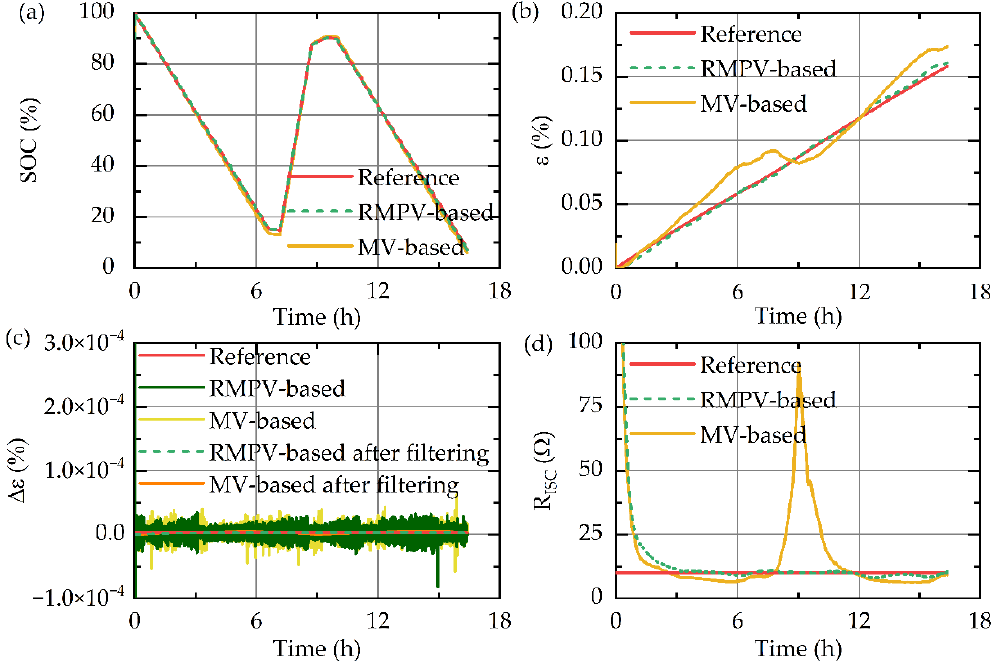
Figure 9. Estimation results with a 10 Ω -ER: ( a ) SOC estimation result; ( b ) estimation result of ε; ( c ) estimation result of Δε; ( d ) R ISC estimation result. Table 1. Statics of SOC estimation errors.